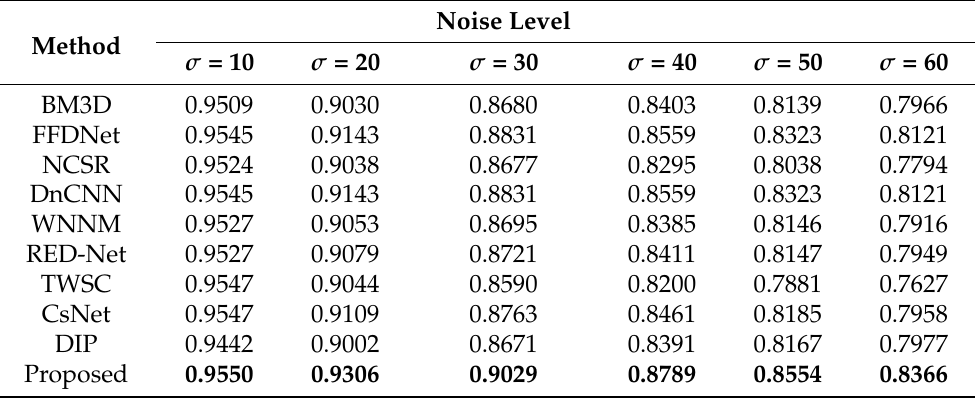
Table 11. Average FSIM results of different methods on BSD50 with various noise